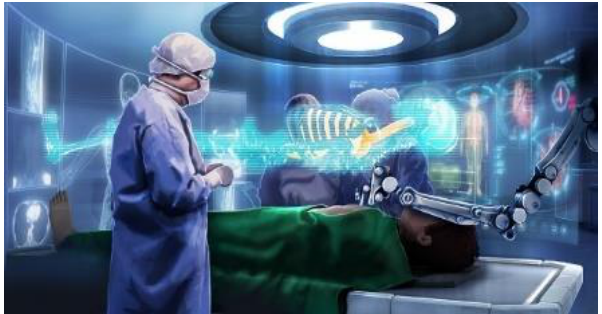
Figure 1 . Future of Surgery : Augmented Reality and Surgical Navigation System . Source : https :// c1 . staticflickr . com / 1 / 486 / 31501281374_81b237b6 5b_b . jpg